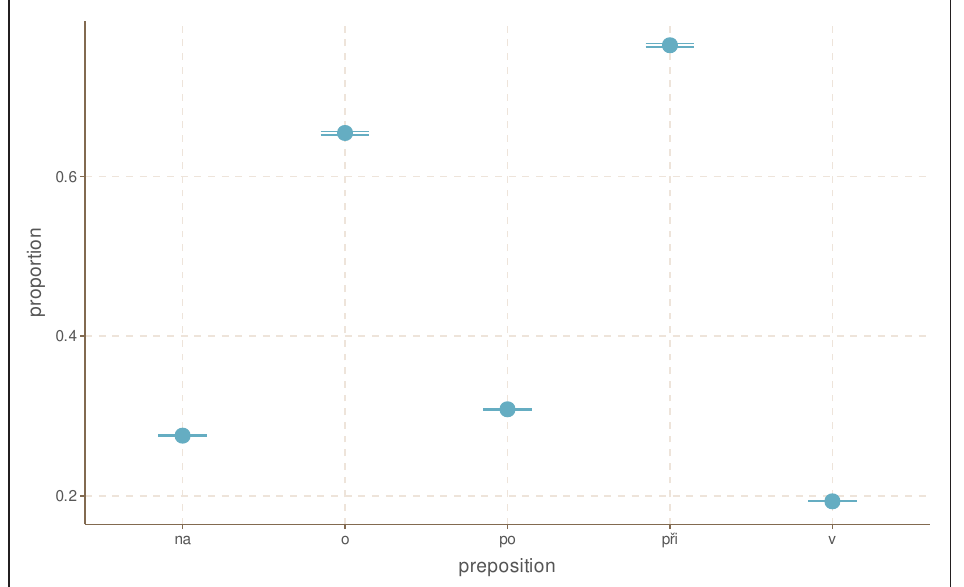
Figure 7 Conditional effects of preposition on proportion of use of - u for overabundant